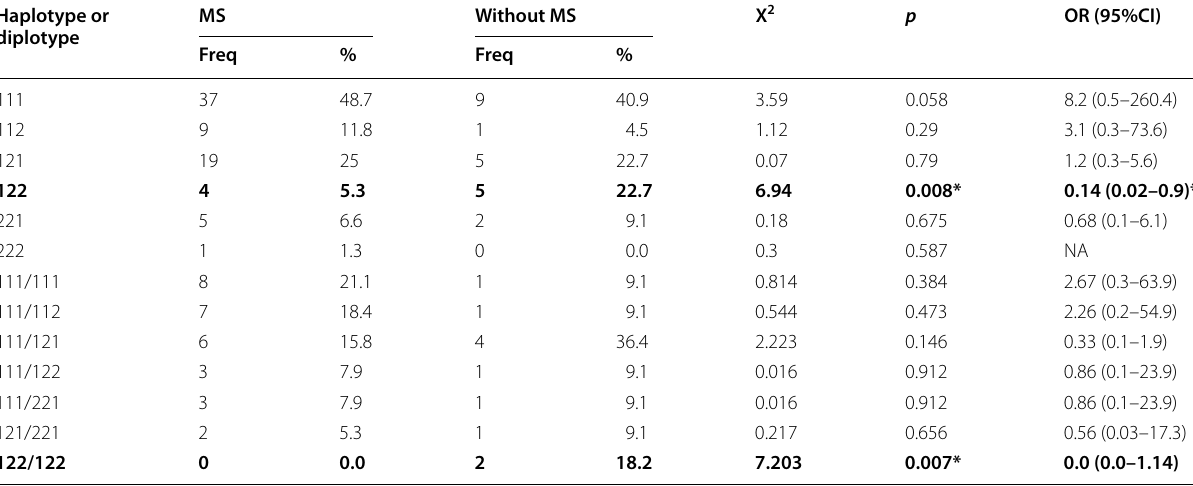
Bold indicates statistical significant result Non‑applicable data were not mentioned